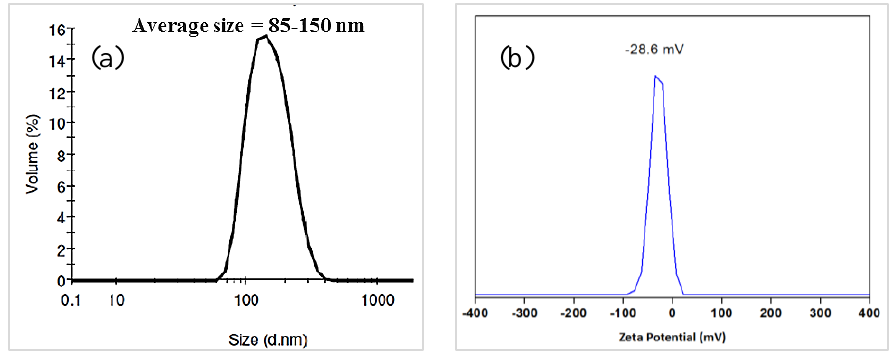
Figure 3. Size distribution ( a ) and zeta potential analysis ( b ) of Magnetic Ethylene-PMO NPs .